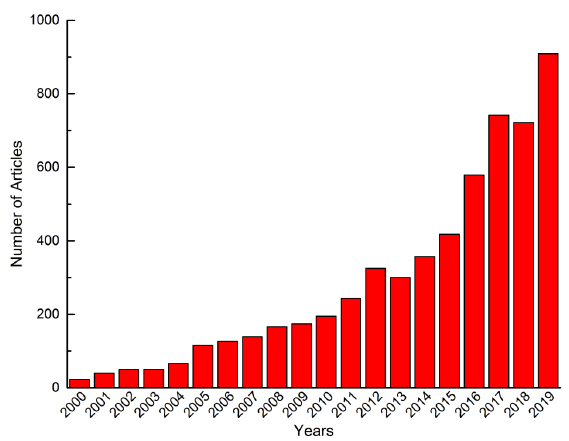
Figure 4. Number of articles focused on polymeric nanocapsules for medical applications (based on statistics of Science Direct).